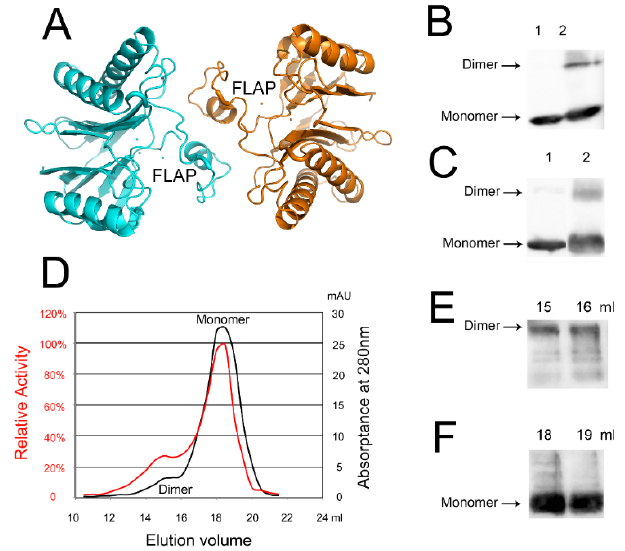
Figure 3. ( A ) Crystal-packing contacts in tPphA structures (PDB: 2J82, 2XZV, 2Y09, 5D2U, and 5ITI) are similar and imply a dimer. For example, in the H39A structure, each H39A molecule forms an asymmetric unit. Two H39A molecules could pack with each other through the FLAP subdomain. ( B ) tPphA cross-linked by glutaraldehyde. A dimer of tPphA is stabilized by glutaraldehyde (the upper band in Lane 2). ( C ) tPphA cross-linked by DTSSP. The conditions in Lane 1 and Lane 2 are the same, except that the tPphA dimer in Lane 1 was decomposed using DTT. There is less tPphA dimer in Lane 1 than in Lane 2. ( D ) tPphA cross-linking products were separated by gel filtration. The activities of the protein fractions were determined by p NPP assay. The cross-linked dimer of tPphA could still dephosphorylate p NPP. ( E , F ) Western blotting. Fractions (15, 16, 18, and 19 mL) from ( D ) were analyzed by Western blotting.